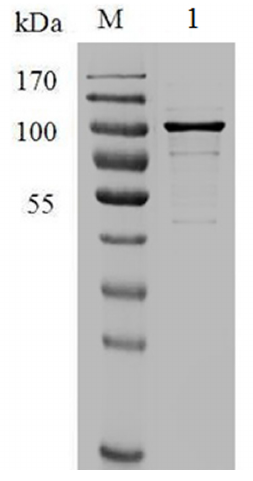
Figure 1. Verification of Hsp90 with sodium dodecyl sulfate-poly- acrylamide gel electrophoresis. Hsp90, 90 Kda heat shock protein. Lane M-molecular weight marker, Lane 1-purified